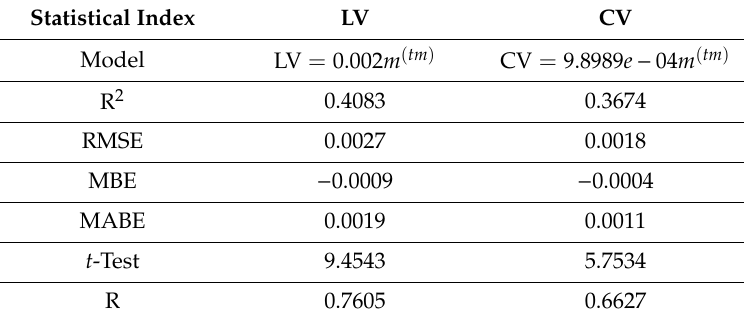
Table 5. The statistical indices of the predicted loose and compact volume of daily waste generation of